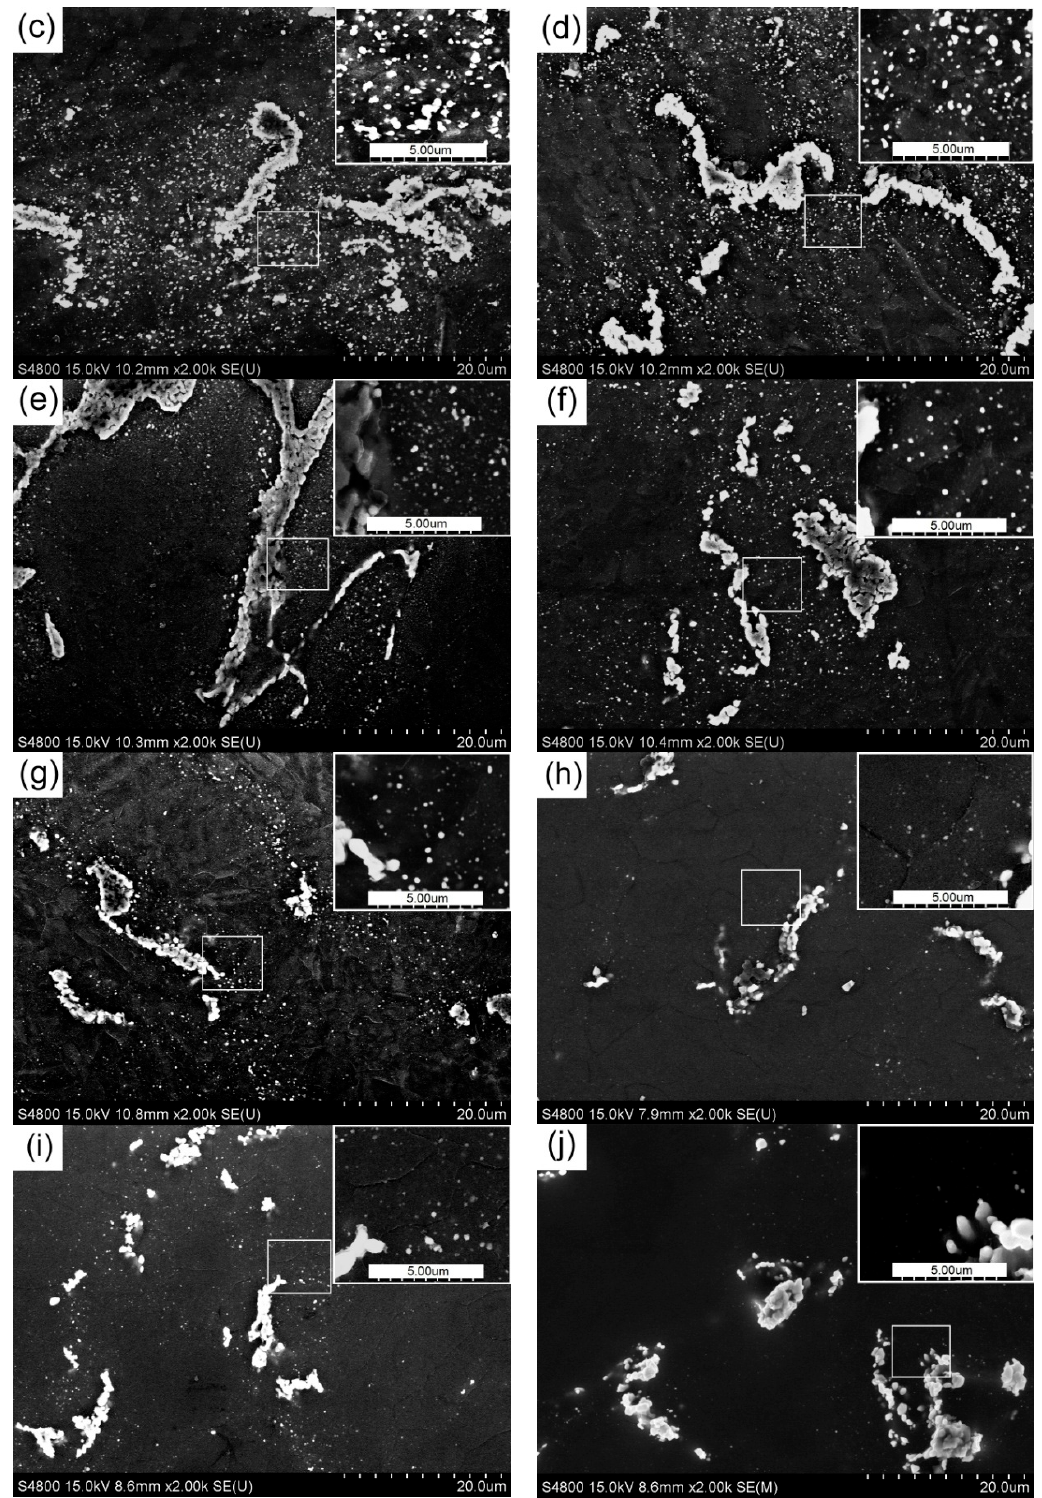
Figure 3. Scanning electron microscopy (SEM) micrographs of Mg-6Zn alloys: ( a ) as-extruded, and after undergoing ECAP for ( b ) two passes at 160 °C, ( c ) four passes at 160 °C, ( d ) six passes at 160 °C, ( e ) two passes at 200 °C, ( f ) four passes at 200 °C, ( g ) six passes at 200 °C, ( h ) two passes at 240 °C, ( i ) four passes at 240 °C, and ( j ) six passes at 240 °C.